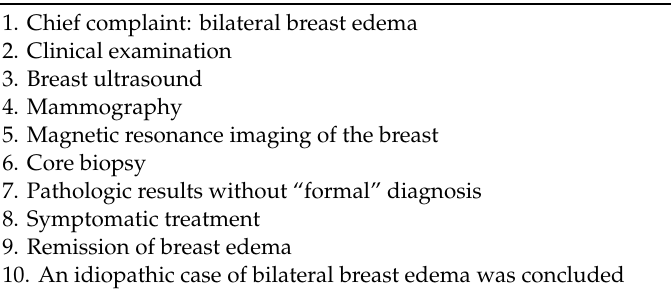
Table 1. Timeline information for the case